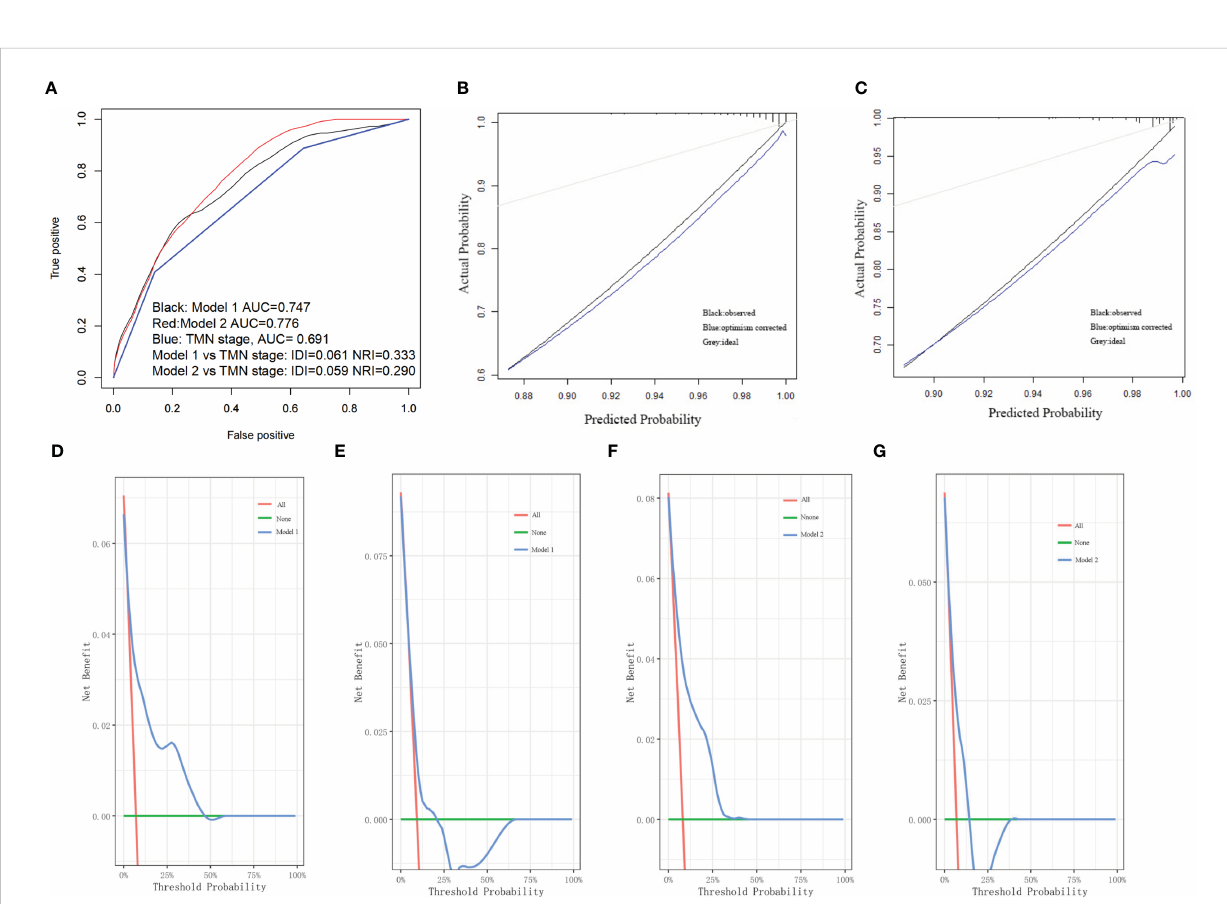
FIGURE 4 (A) Both model 1 and model 2 showed better predictive value than TMN stage in the ROC analyses. (B) The calibration curve of model 1. (C) The calibration curve of model 2. (D) The DCA of model 1 in the development cohort. (E) The DCA of model 1 in the validation cohort. (F) The DCA of model 2 in the development cohort. (G) The DCA of model 2 in the validation